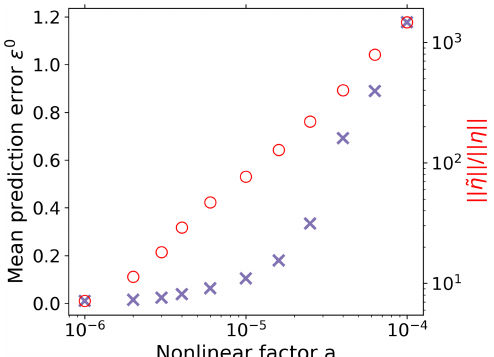
Figure 7. Mean prediction error (Eq. 37) of the recovery when de- riving χ(t) for different values of the nonlinearity factor a of the toy model. As a increases, the recovery of χ(t) deteriorates because the level of the contributions from nonlinearities || (cid:101) η || becomes large compared to the noise level || η || ; how these terms are computed for the toy model is explained in Appendix D. To demonstrate here the pure effect from the breakdown of the spectral similarity assump- tion, the RFI algorithm is used here without the additional noise- level adjustment enforcing